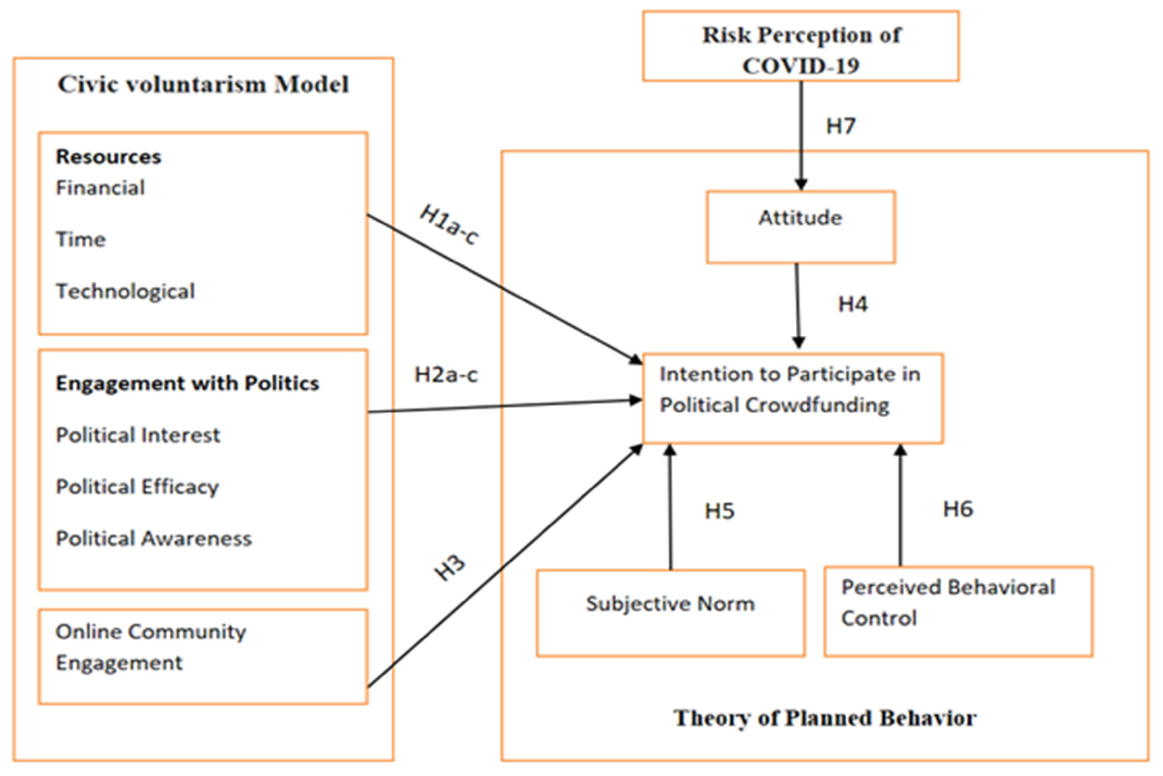
Figure 1. The proposed model of political crowdfunding attitude, intention, and behavior.